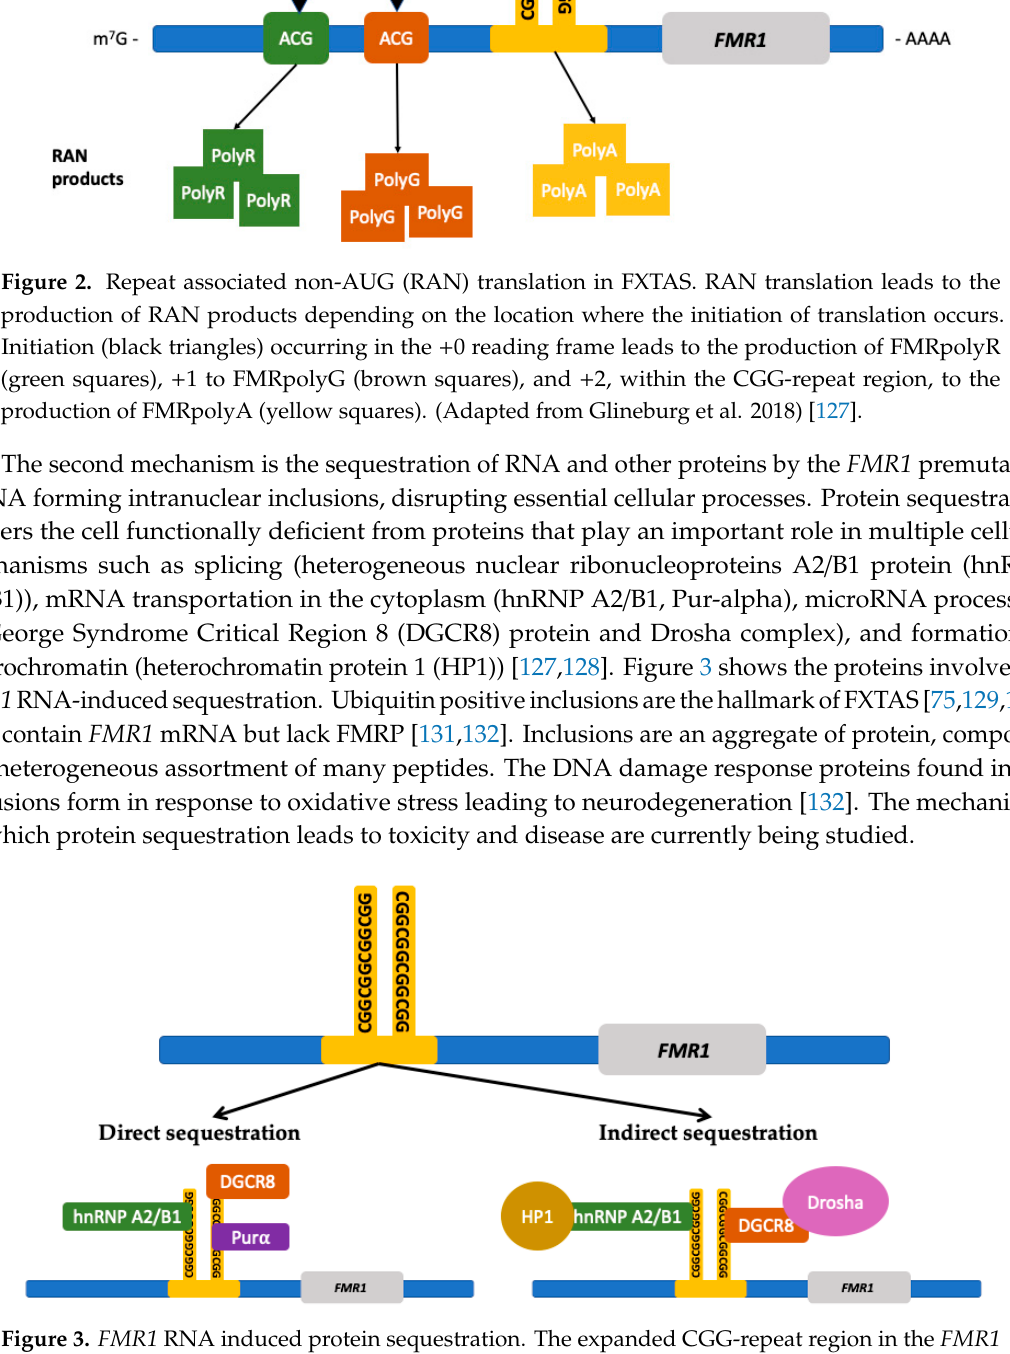
Figure 3. FMR1 RNA induced protein sequestration. The expanded CGG-repeat region in the FMR1 free mRNA can form higher-order structures that can sequester proteins which results in a deficiency within the cell from those proteins. The CGG-repeat region is directly bound by repeat binding proteins such as heterogeneous nuclear ribonucleoproteins A2 / B1 (hnRNP A2 / B1), DiGeorge syndrome critical region 8 (DGCR8) protein, and Pur-alpha ((Pur α ) protein. The CGG-repeat region can also indirectly sequester other proteins through the interaction with the directly bound proteins. Proteins that can be indirectly sequestered include Drosha and heterochromatin protein 1 (HP1). (Adapted from Hagerman and Hagerman 2016 and Glineburg et al. 2018)